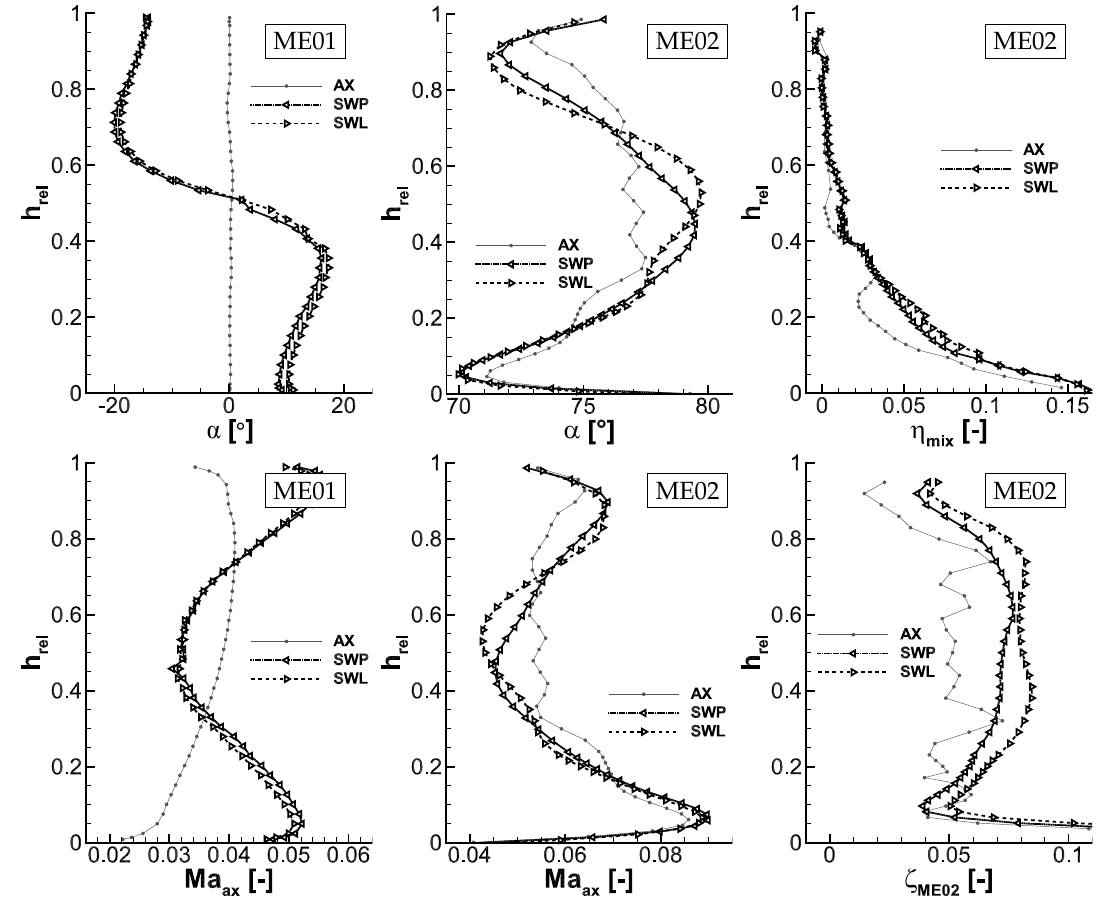
Figure 11. Pitch-wise area-averaged whirl angles α and axial Mach numbers for both inlet (ME01) and exit flow (ME02); ζ and η mix -profile in ME02. All shown for MFR 3.